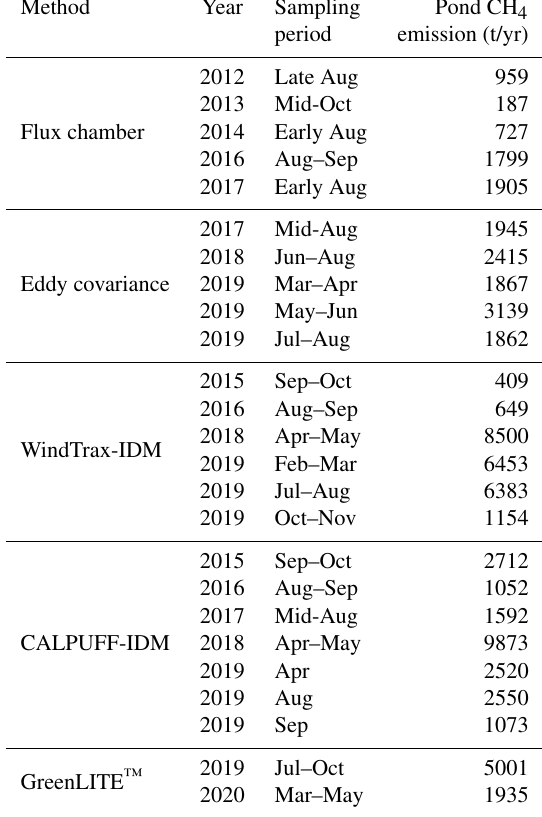
Table A2. Historical open-pit mine emission studies (AECOM Canada Ltd., 2021).